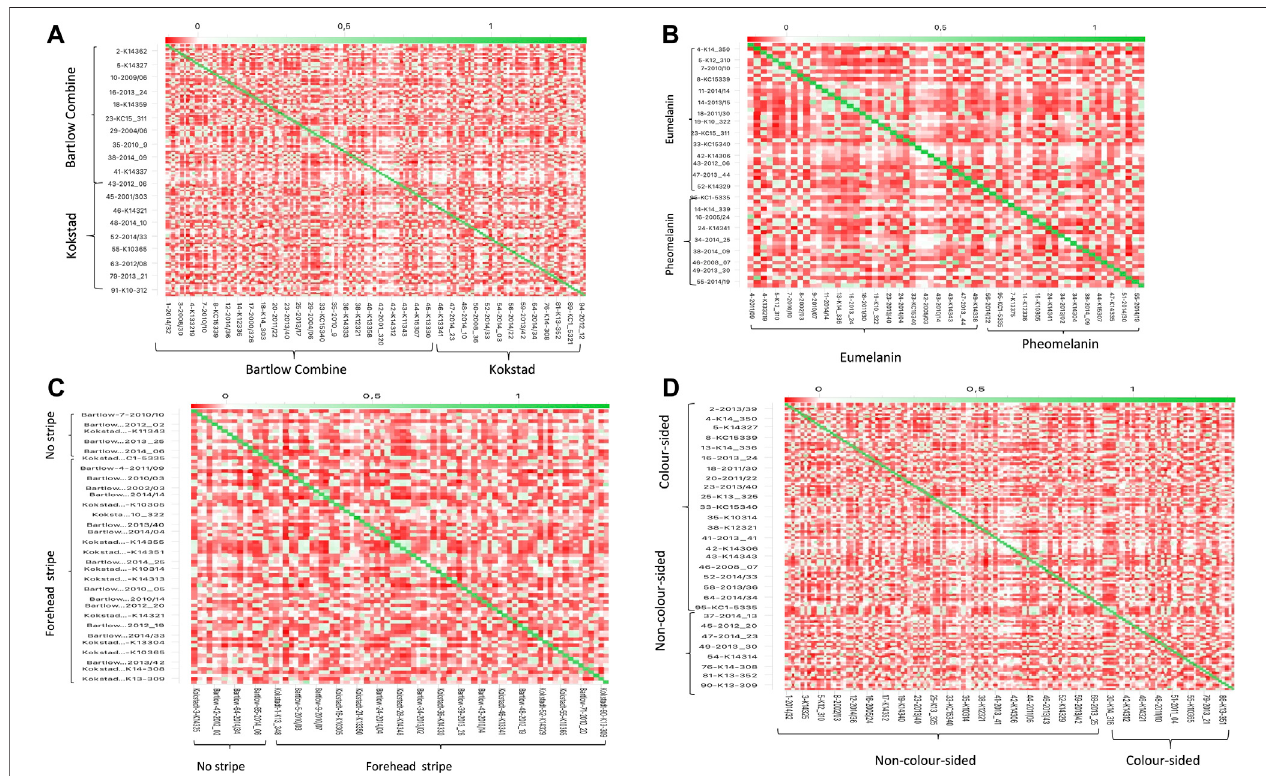
FIGURE3| HeatMapofthegenomicrelationshipmatrixfor (A) BartlowCombineandKokstadtconservationstations; (B) EumelaninandpheomelaninNgunicattle (C) Nguni cattle with or without forehead stripes and (D) colour sidedness and non-colour sided Nguni cattle. The animal identities (IDs) are shown on the x and y -axis.